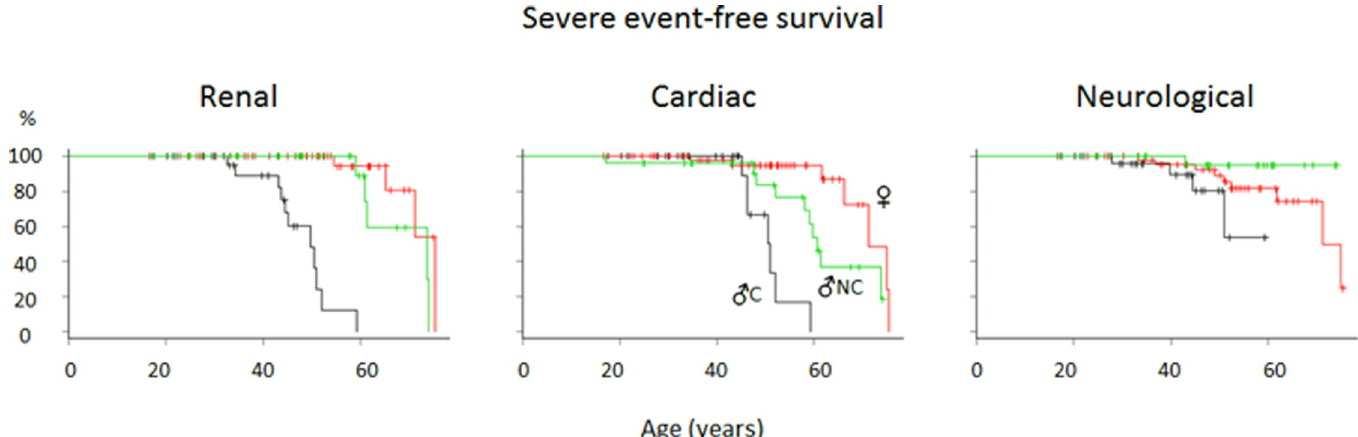
Fig 4. Renal, cardiac and neurological severe event-free survival curves (black: Classical group males, green: Nonclassical group males, red: Females).